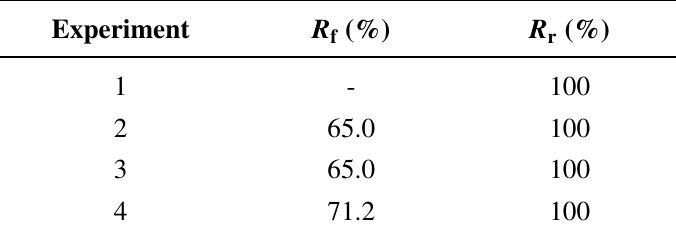
Figure 6. Cyclic thermomechanical response of PCO+2%DCP sample elongated at different forces. Table 3. Shape fixity and shape recovery ratios for a PCO+2%DCP sample tested at different conditions.